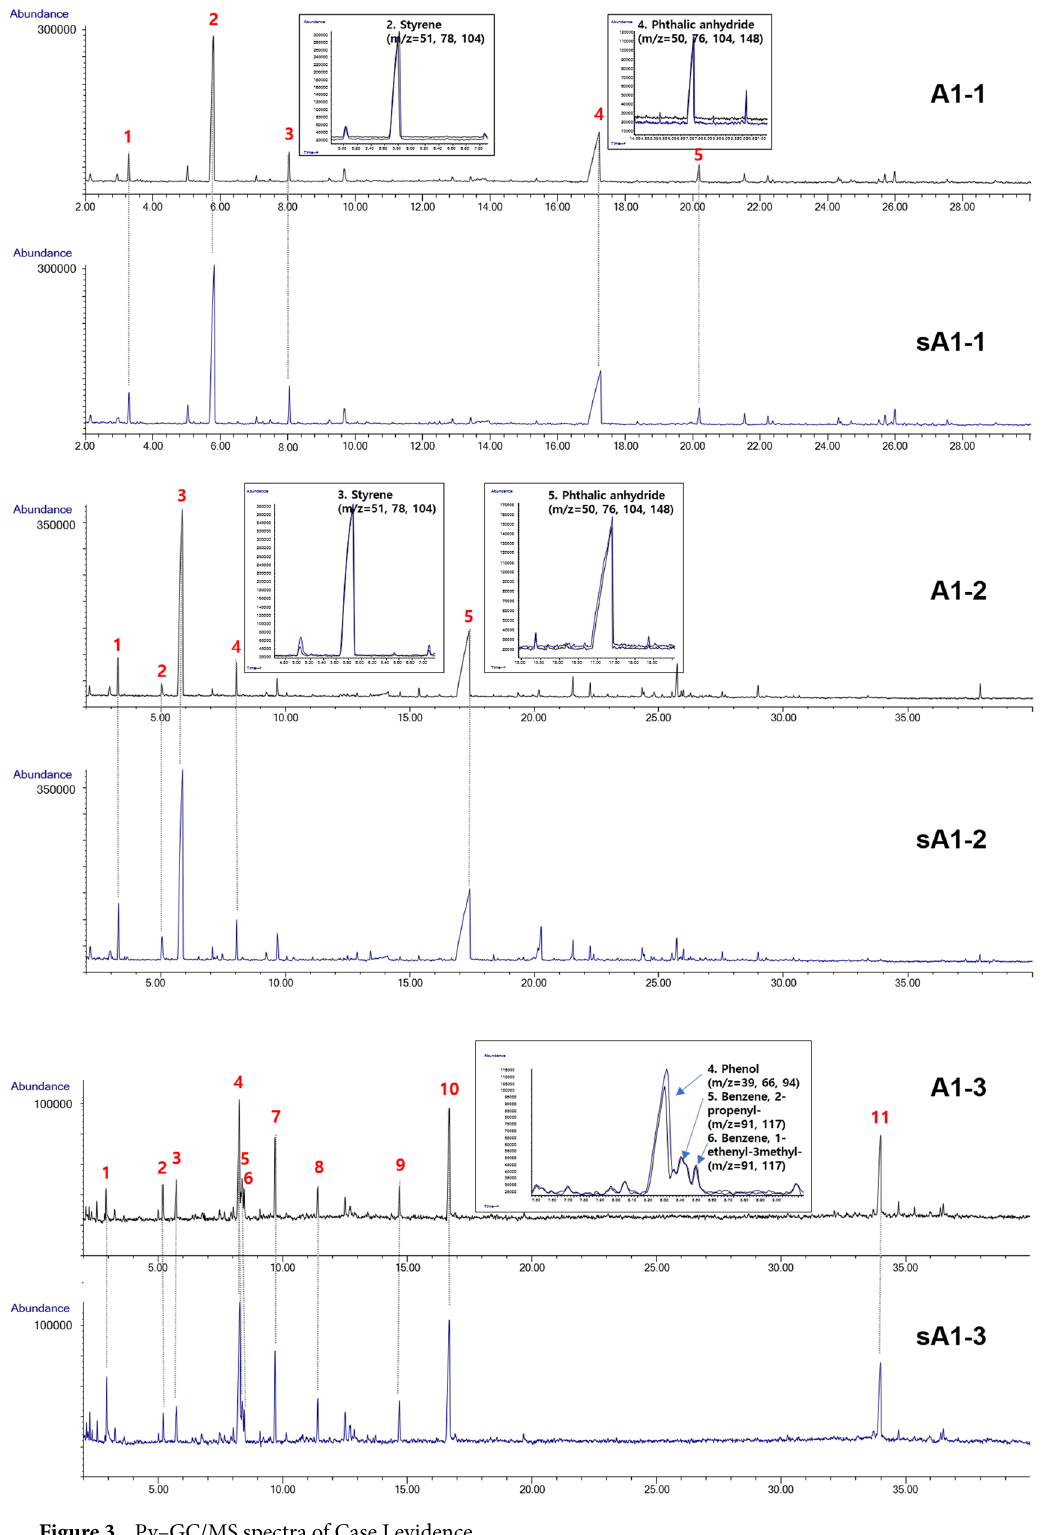
Figure 3. Py–GC/MS spectra of Case I